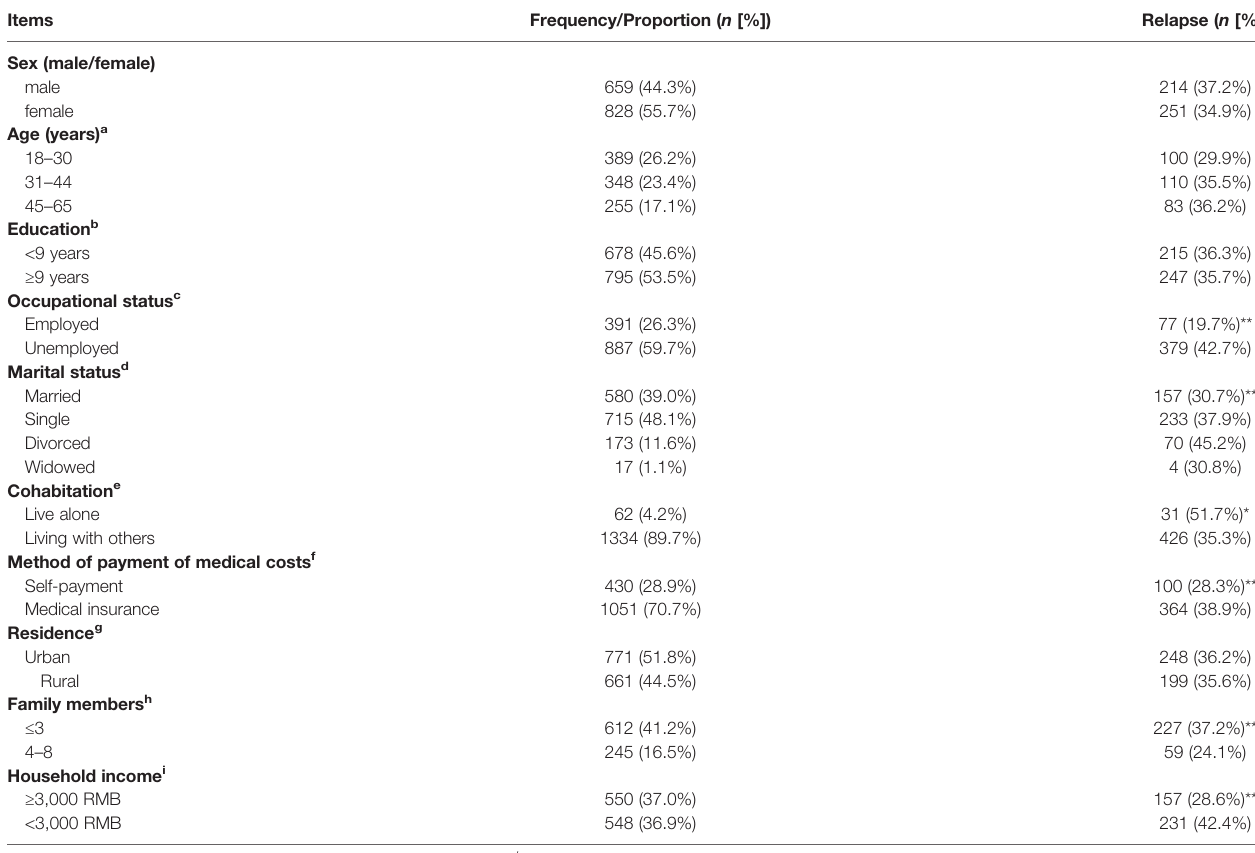
TABLE 1-1 | General demographic and disease information of the patients